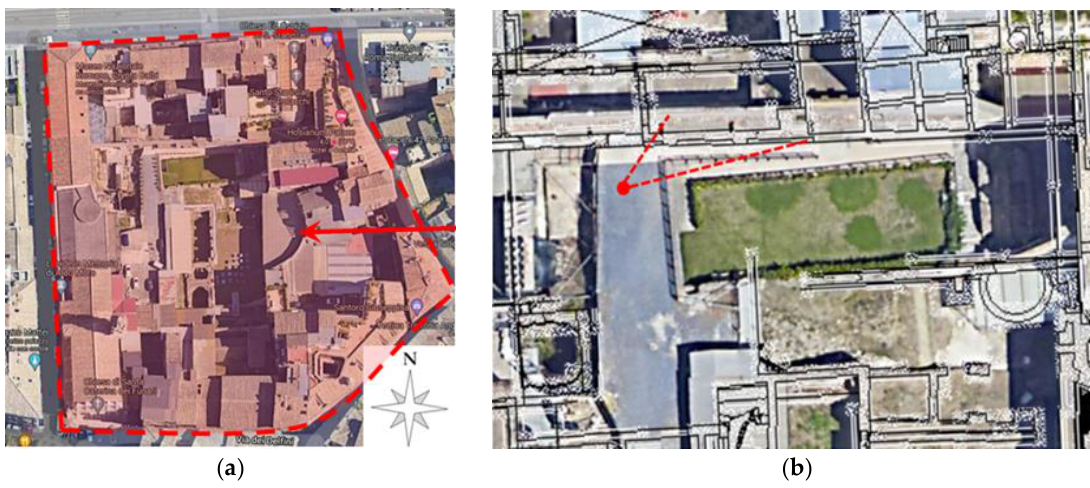
Figure 12. The so-called Crypta Balbi in Rome: ( a ) Aerial photo of the archeological site (from Google Maps). The red arrow indicates the exedra. ( b ) Video acquisition geometry with camera position and field of view (in red) of the 16th-century wall.